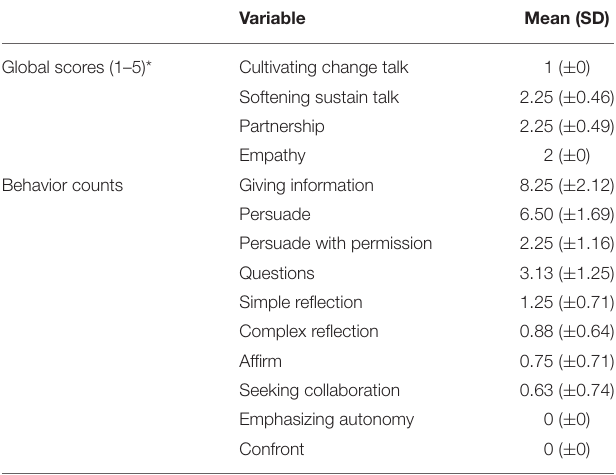
TABLE 1 | Descriptive statistics (mean ± standard deviation) of 14 variables (global scores and behavior counts) describing MI-skills according to MITI